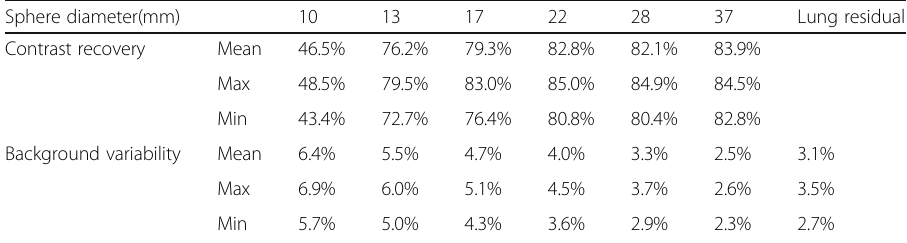
Table 2 Mean-, max-, and min-percentages of contrast recovery, background variability, and lung residual for the 4:1 sphere-to-background ratio for three sequential measurements of IEC image quality